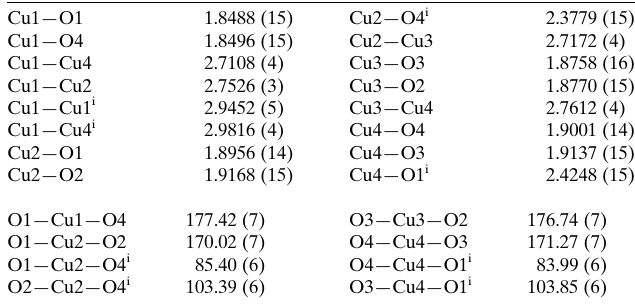
Table 1 Selected geometric parameters (A˚ , (cid:2) ).